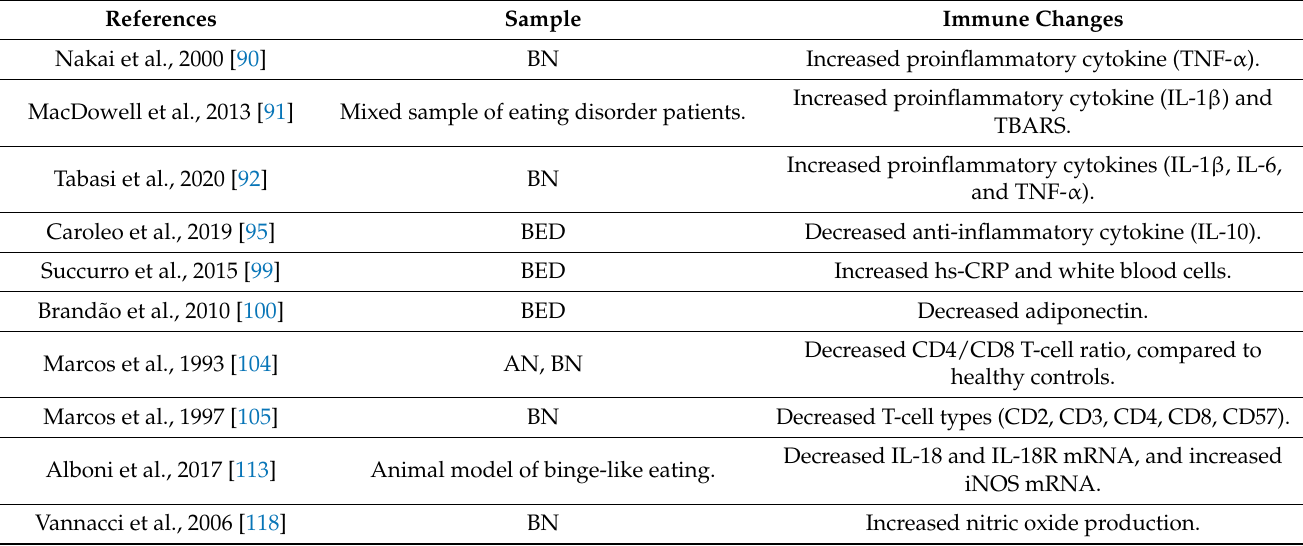
Table 3. Summary of the immune changes in bulimia nervosa (BN), binge eating disorder (BED), and animal models of binge-like